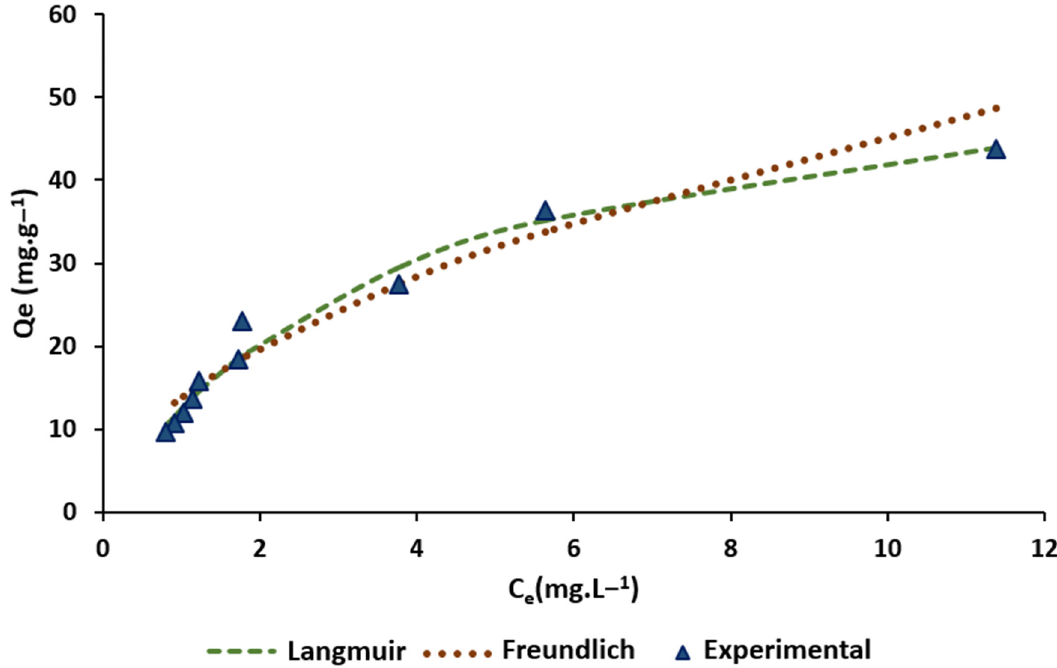
Figure 6. Experimental and theoretical isotherm values of CPX on F Zn (180 min: adsorbent amount 0.02 to 0.2 g). The Langmuir separation factor ( R L ) in Equation (5) was used to determine if the adsorption process was irreversible ( R L = 0), linear ( R L = 1), favorable (0 < R L < 1), or unfavorable ( R L > 1) [38]. In this study, R L = 0.15 was considered to indicate that the CPX adsorption on F Zn was favorable. The maximum monolayer adsorption capacity ( Q m ) was 57.47 mg/g, which is comparable to values reported for CPX adsorption with several types of biomass (Table